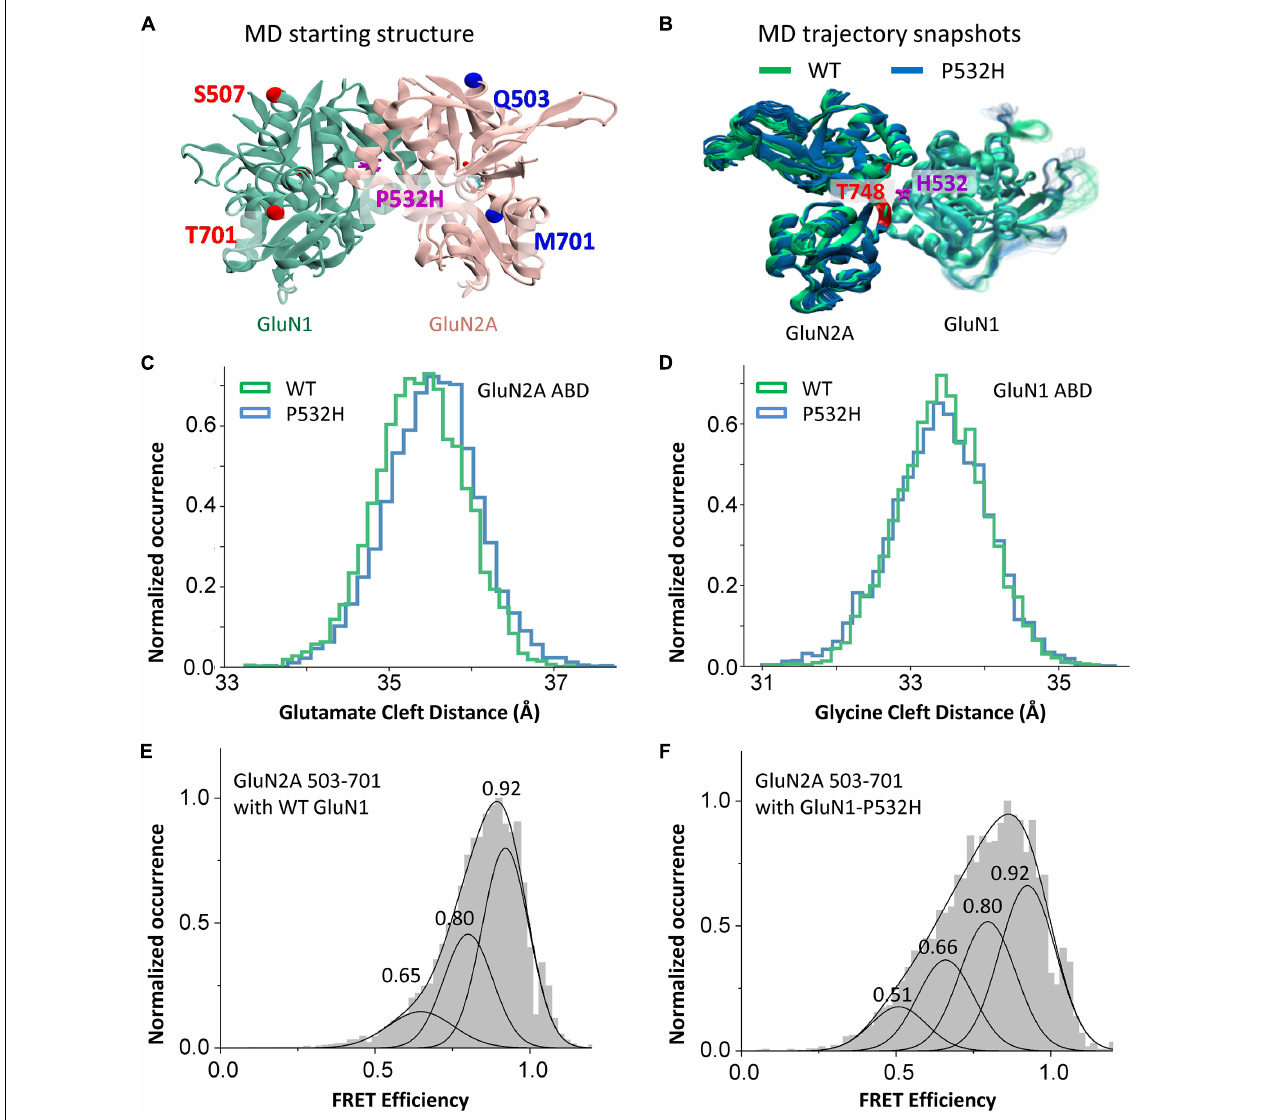
FIGURE 4 | Effects of GluN1-P532H variant on agonist-binding domain cleft distance. (A) Agonist-binding domain (ABD) dimer, GluN1 (green) and GluN2A (rose), used for MD simulation showing sites for measuring distances. (B) Structures from MD trajectory taken from 150 to 300 ns of simulations for wild-type (green) and GluN1-P532H variant (blue). Each frame in the figure represents the conformation of every 7.5 ns simulation time. (C,D) Histogram of distance measurement between the C α atoms of sites Gln503 and Met701 in GluN2A (C) and Ser507 and Thr701 in GluN1 (D) , as seen in the MD simulation. (E,F) Normalized cumulative single-molecule FRET efficiency histograms depicting changes across the cleft (between sites 503 and 731) of glutamate-binding domain of GluN2A subunit in wild-type (E) and GluN1-P532H (F) bound to glutamate and glycine. The FRET efficiency states estimated by Gaussian fitting are listed and are shown in FRET efficiency traces in Supplementary Figures 1–5